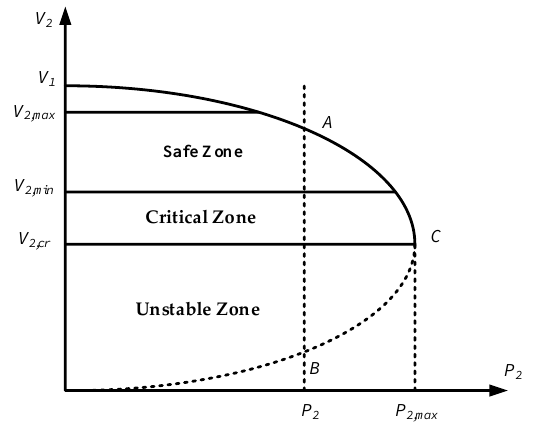
Figure 4. The load P-V curve of simple power system. Point A in is the stable operation point, and point B is the unstable point, Point C is the critical point of system.